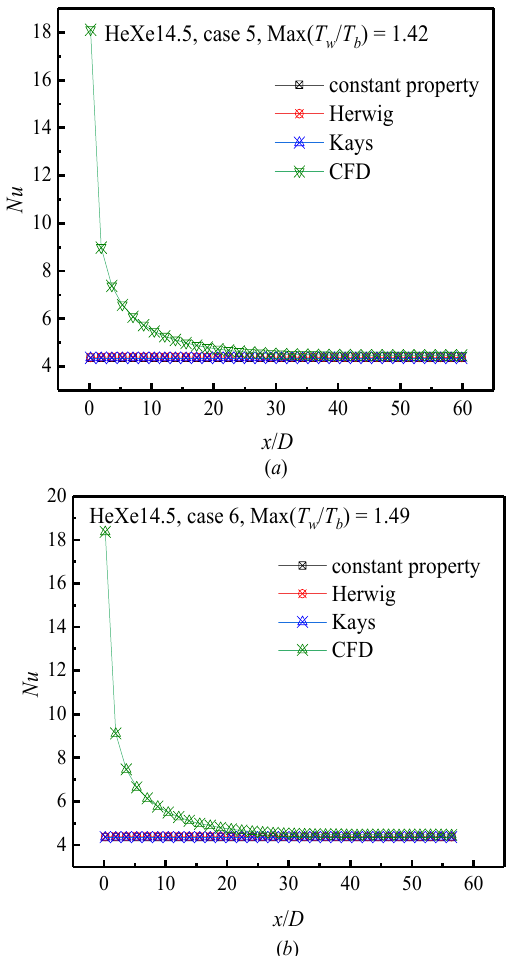
Figure 8. Calculations by existing Nu correlations for HeXe14.5. ( a ) case 5; ( b ) case 6.